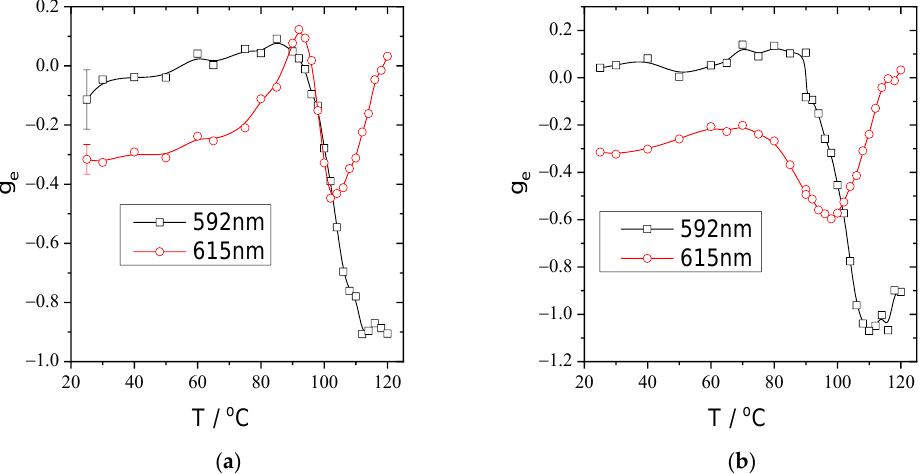
Figure 7. Temperature dependencies of the dissymmetry factor at two wavelengths recorded during heating ( a ) and cooling ( b ). The rate of the temperature changes is 1 °C/min. Figure 8 shows the temperature dependencies of | g e | at 592 nm and the corre- sponding sensitivity Sr calculated using Equation (3): 𝑑𝑔 𝑒 𝑑𝑇⁄ , (3) 𝑆𝑟 = −1 𝑔 ⁄ 𝑒 It is noteworthy that Sr reaches ca. 65% when the mixture film is heated. This is an extremely high value, which is several times higher than the highest sensitivity values for classic luminescent thermometry materials obtained to date (i.e., 31%/K at 4 K [22] and 12%/K at 125 K [23]), and an order of magnitude higher than that of thermometers at el- evated temperature (i.e., 5.44%/K at 90 °C [24], 4%/K at 100 °C [25], 4.6%/K at 40 °C [26], 1.8%/K at 120 °C [27]). This value is also 15 times higher than the value obtained in our previous paper on temperature-dependent CPL [15].